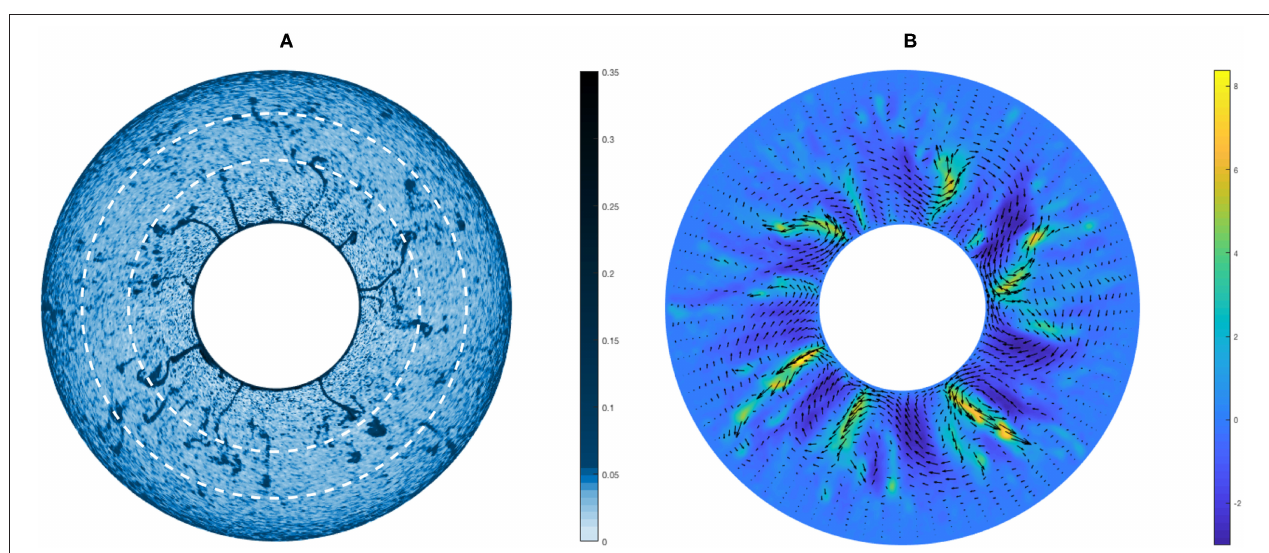
FIGURE 9 | (A) Equatorial section of the compositional field at t 6 for case 1. The color scale has been saturated so that the top stratified layer becomes more = apparent. The white dashed lines delimit qualitatively three regions in the spherical shell: a bottom plumes region, an intermediate more or less well mixed blobs region and a stratified layer at the top. (B) Equatorial section of the radial velocity field (in color) for the same snapshot. Arrows denote local horizontal velocity vectors.